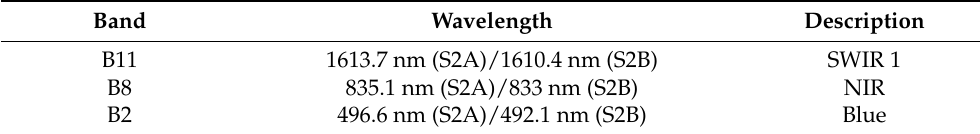
Table 2. Band combinations for monitoring crop health using Sentinel-2